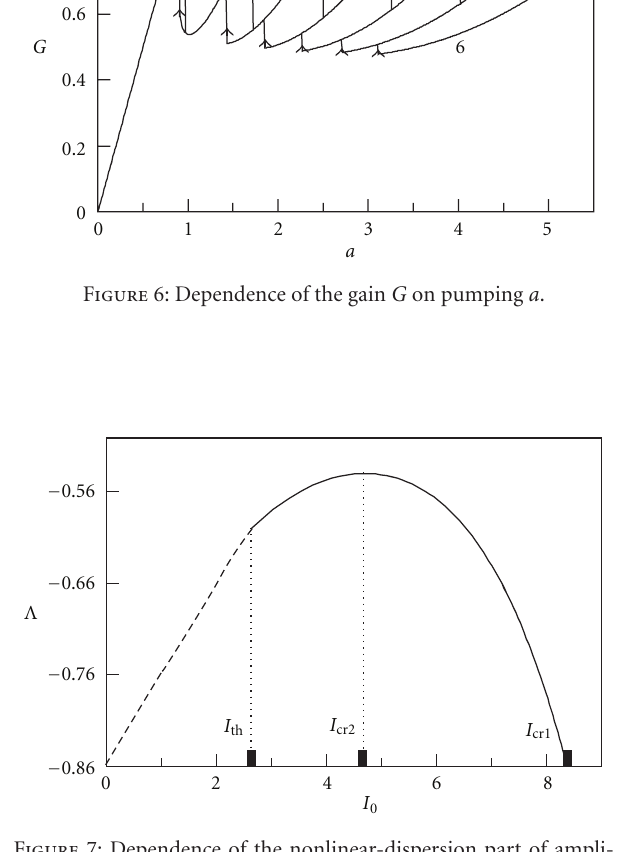
Figure 7: Dependence of the nonlinear-dispersion part of ampli- fication for intracavity pulses Λ on their peak intensity I 0 . The fragment of an unstable single-pulse generation is shown as a dashed line. The value I cr 2 corresponds maximum Λ = Λ ( I 0 ). Λ ( I = Λ cr 1 )